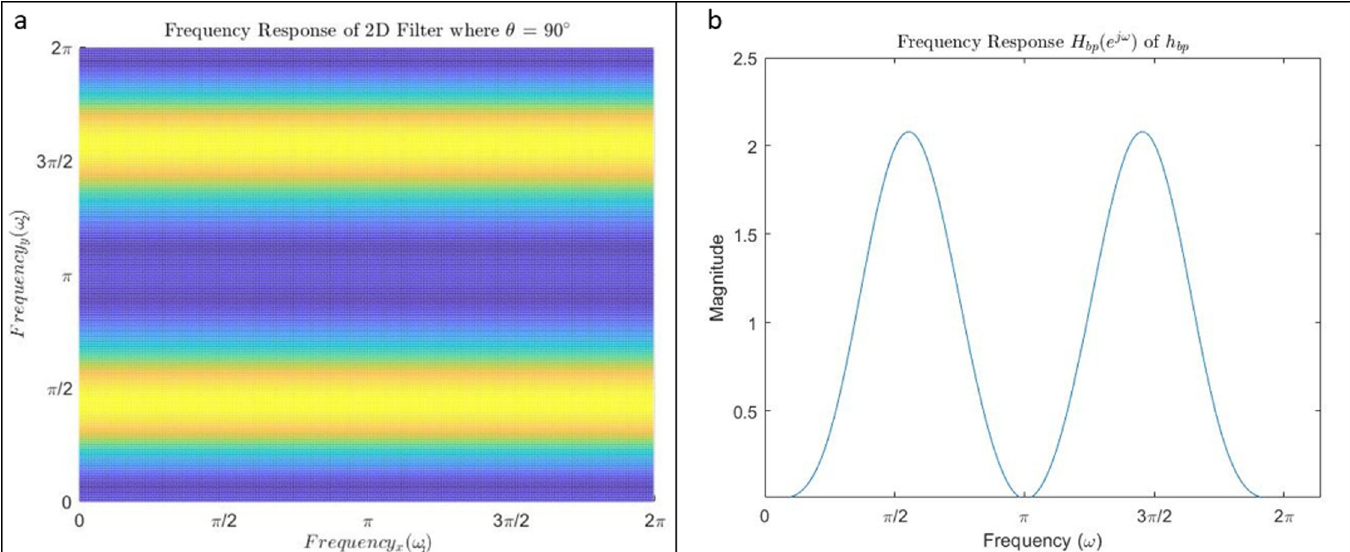
Fig 1. (a) The frequency response H the vertical edge filter. This filter